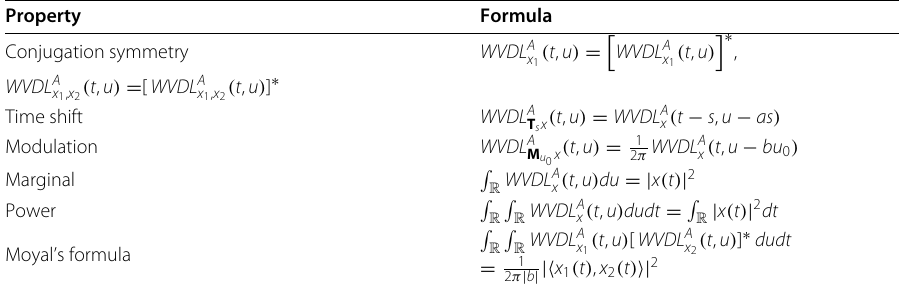
Table 3 Basic properties of new WVDL Property Formula Conjugation symmetry